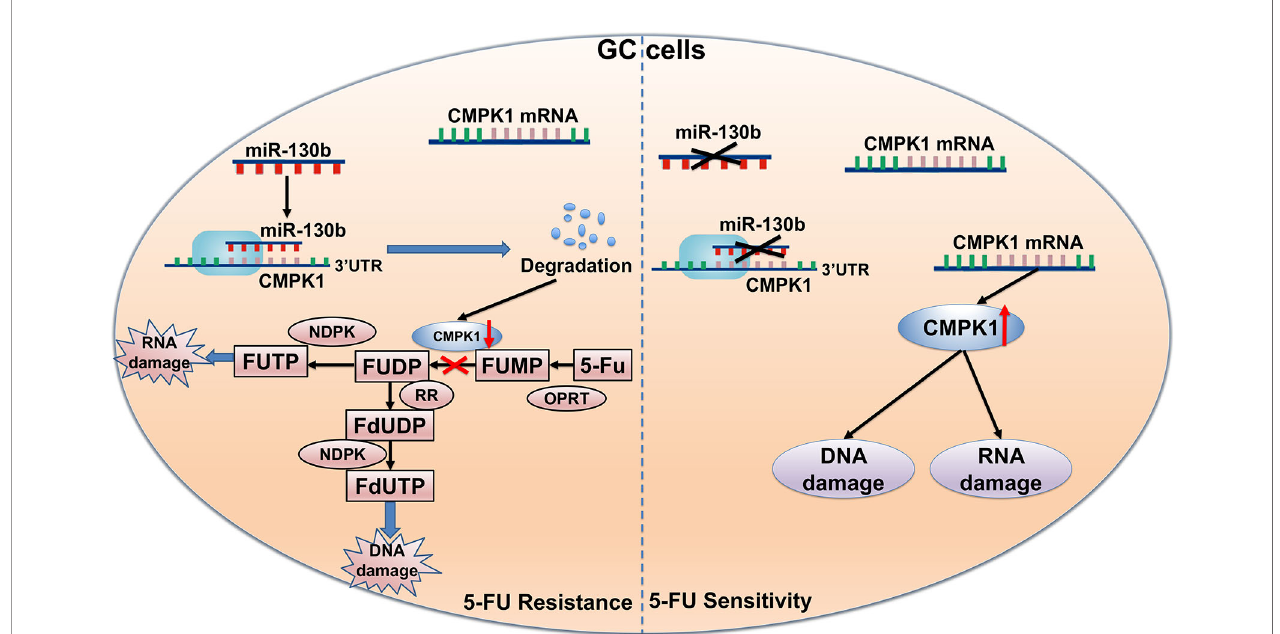
FIGURE 6 | Schematic of the proposed molecular mechanism of miR-130b in GC affecting 5-FU metabolism. First, 5-FU is converted to FUMP in vivo by OPRT. MiR-130b directly targets CMPK1 expression and suppresses the phosphorylation of 5-FU FUMP to the diphosphate metabolites FUDP and FdUDP. As a result, miR-130b attenuates the response of gastric cancer cells to chemotherapy and impacts survival. FUMP, 5- fl uorouridine-5 ′ -monophosphate; FUDP, 5- fl uorouridine- 5 ′ -diphosphate; FdUDP, 5- fl uoro-2 ′ -deoxyuridine-5 ′